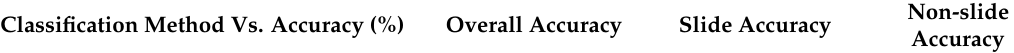
Table 4. Accuracy analysis of the MD using Euclidean and Mahalanobis distance, SVM, and ML classification, for the slide and non-slide